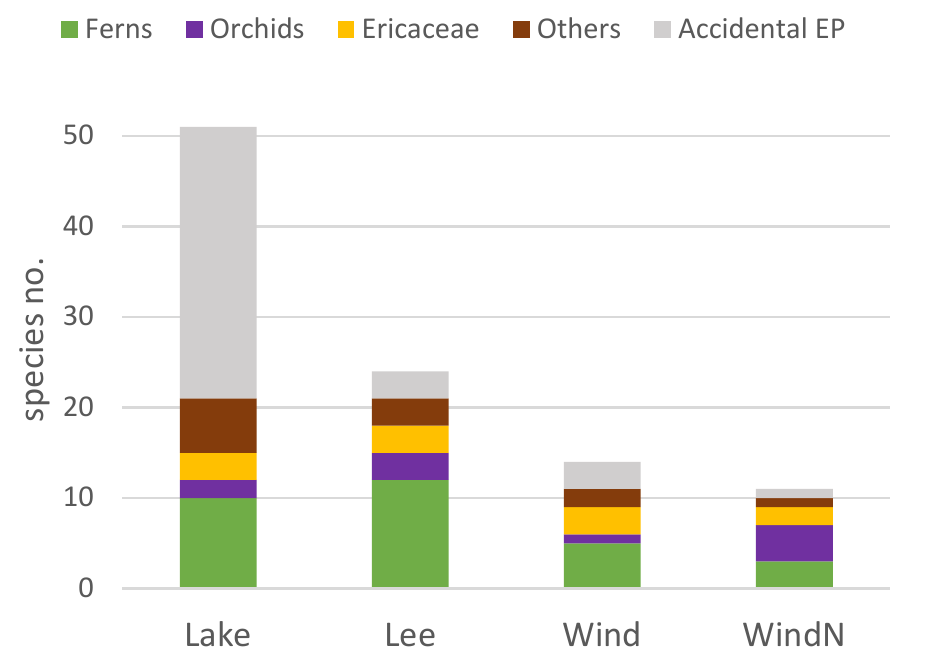
Figure 4. Recorded species and the floristic composition of epiphytes at the four sites. Epiphytic ferns and orchids were most abundant, followed by epiphytic Ericaceae. Table 3. Epiphyte abundance within crown locations at the four sites.